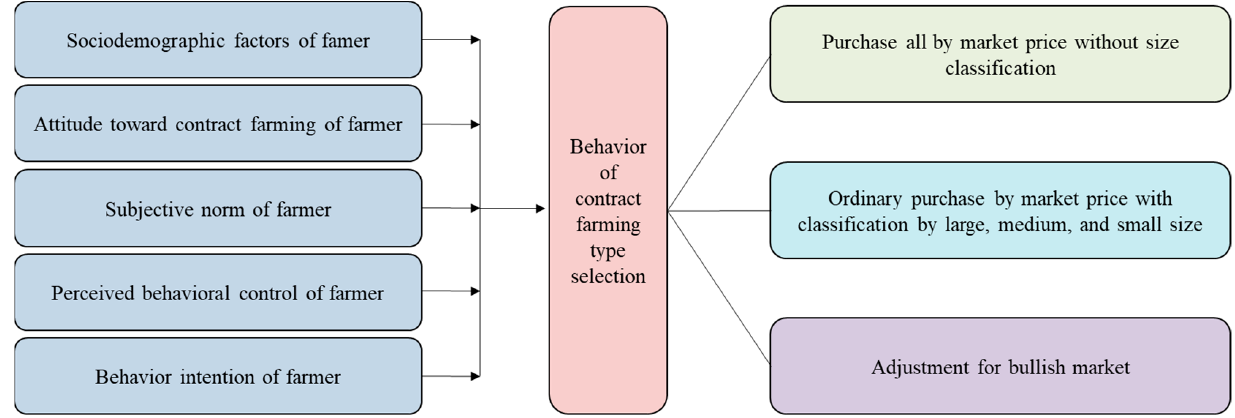
Figure 1. Framework of the TPB for selecting the type of contract farming for sweet potatoes.